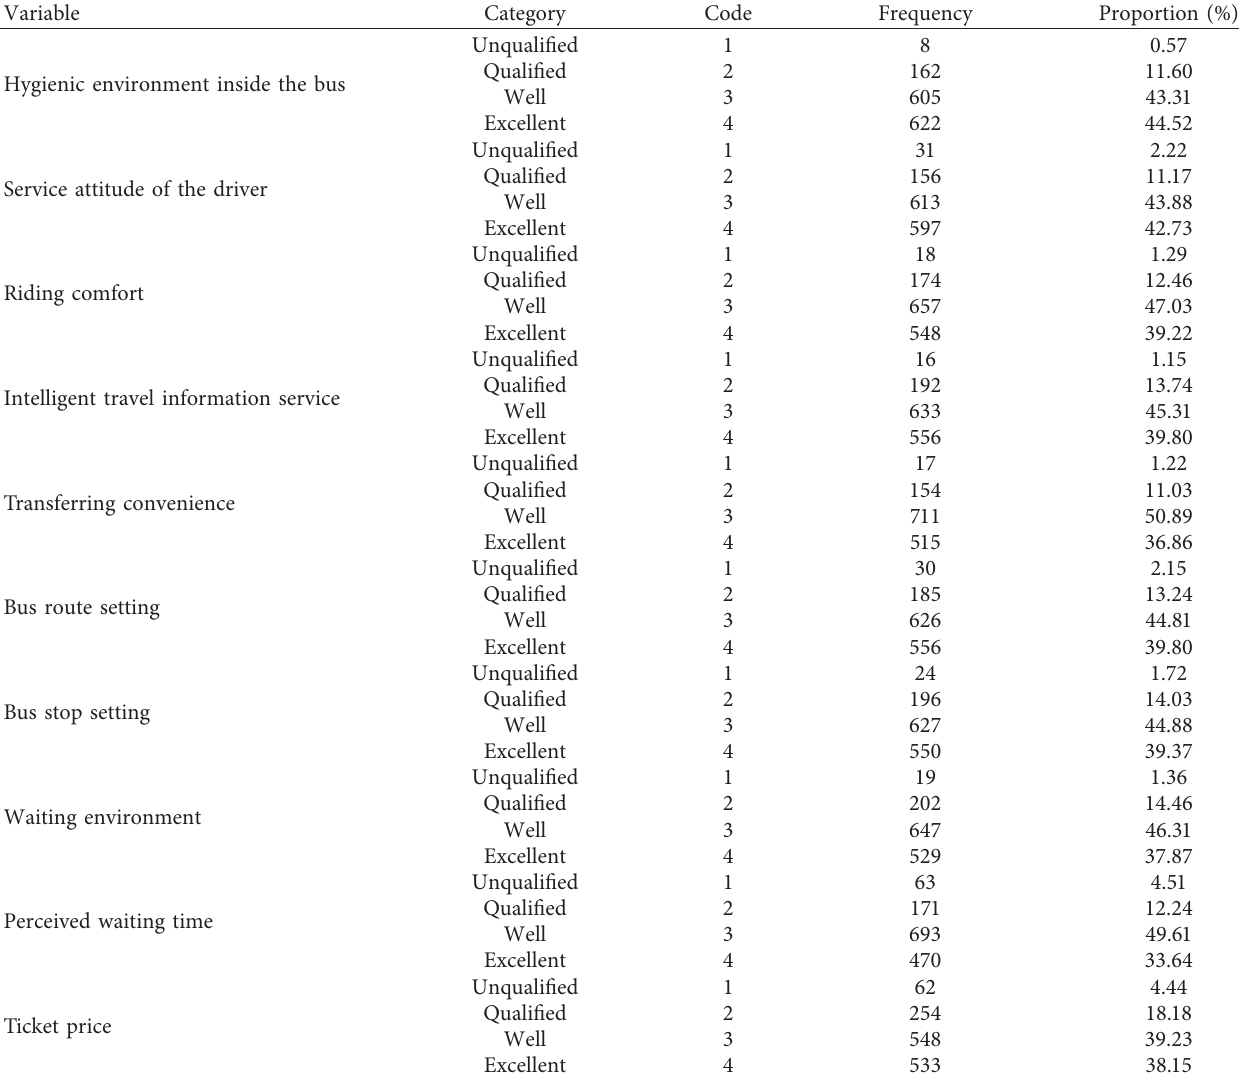
Table 3: Respondents’ service quality perception